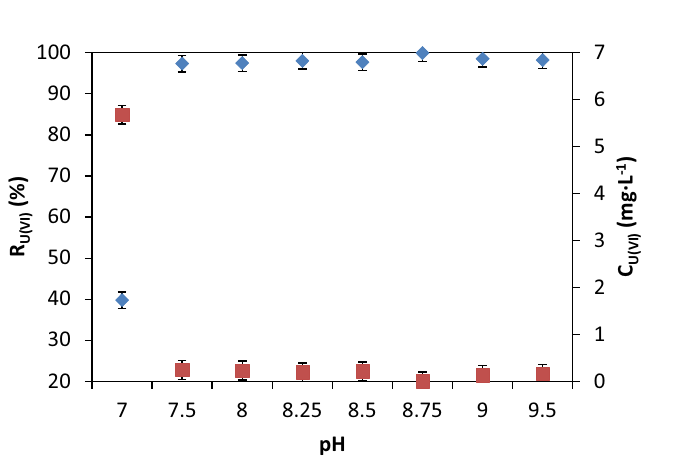
Figure 2. Fe (III) aqueous species in the mixture U(VI) + Fe(III) calculated by Phreecq Interactive 3.1.1-8288 software using llanl.dat database.